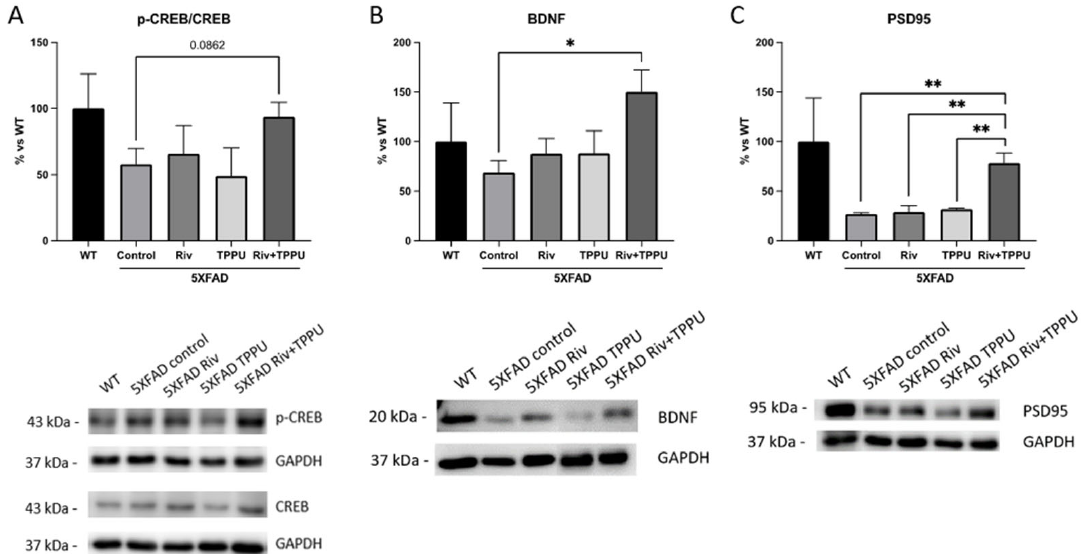
Figure 5. Effects of drug combination and monotherapies on neuronal plasticity in 5XFAD mice. Representative WB and quantification of ( A ) p ‐ CREB/CREB ratio, ( B ) BDNF and ( C ) PSD95. Results are expressed as a mean ± SEM. WT, n = 3; 5XFAD control, n = 3; 5XFAD treated with TPPU (1 mg/kg/day), n = 3; 5XFAD treated with Riv (1 mg/kg/day), n = 3; 5XFAD subjected to co ‐ treatment with TPPU (1 mg/kg/day) plus Riv (1 mg/kg/day), n = 4. Groups were compared by the one ‐ way ANOVA test and post ‐ hoc Tukey test. * p < 0.05; ** p < 0.01. Abbreviations: Riv = rivastigmine; CREB = cAMP response element ‐ binding protein; BDNF = brain ‐ derived neurotrophic factor; PSD95 = postsynaptic density protein.